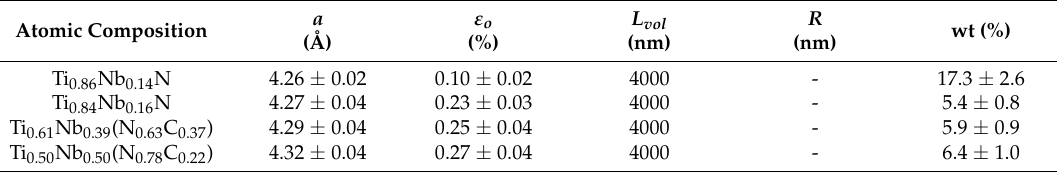
Table 5. Refinement results for TWX70 steel.